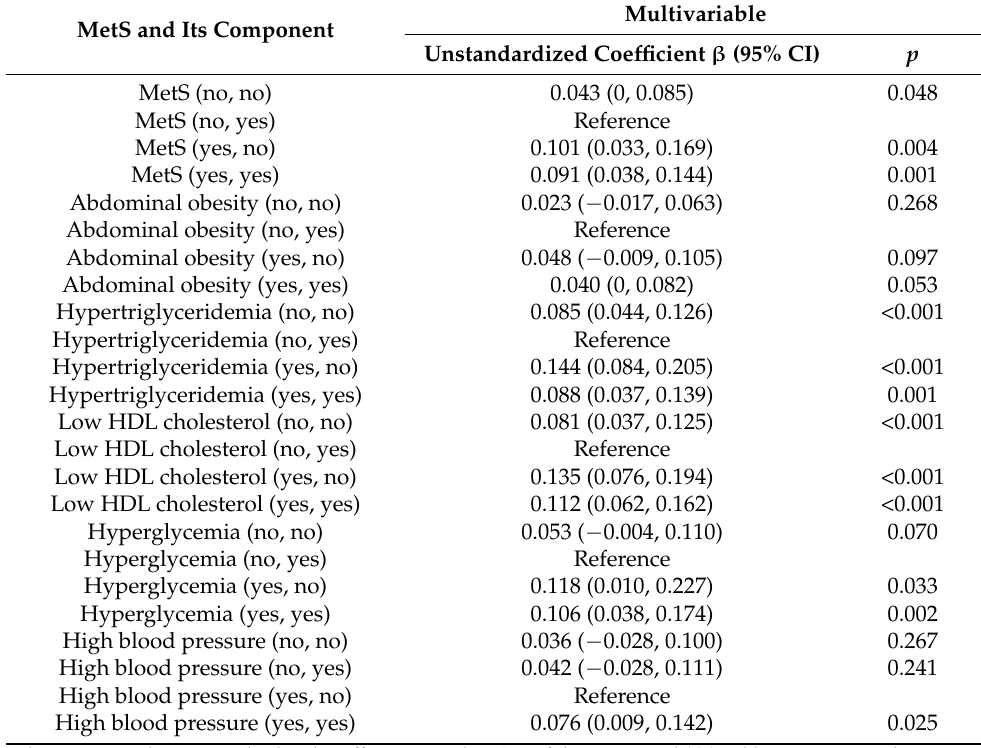
Table 3. Association between MetS and its five components (baseline, follow-up) with BMD (cid:52) T-score using multivariable linear regression analysis in participants. MetS and Its